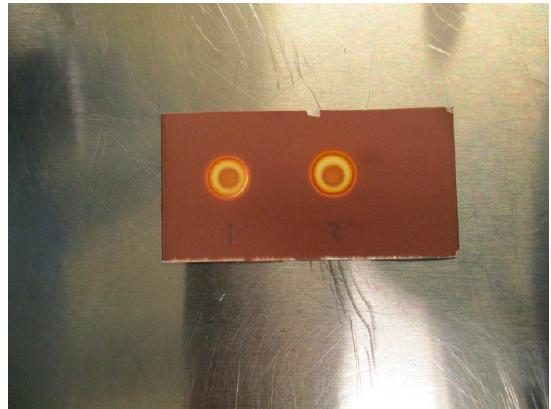
Figure 6. (1) TBA standard (0.26 mg/mL) + H 2 O 2 (1% w/w), (2) TBA standard (0.26 mg/mL) + H 2 O 2 (3% w/w).